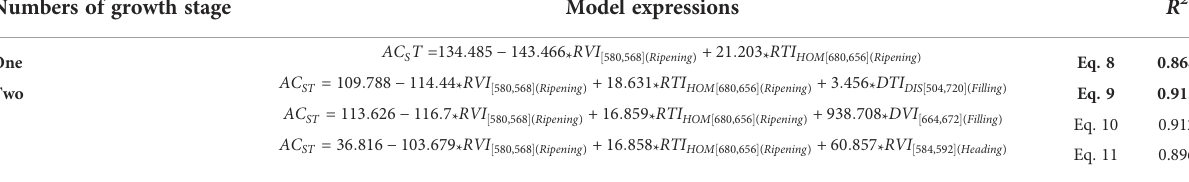
TABLE 7 Formula and coef fi cient of determination ( R 2 ) of the models based on combined spectral and textural variables. Numbers of growth